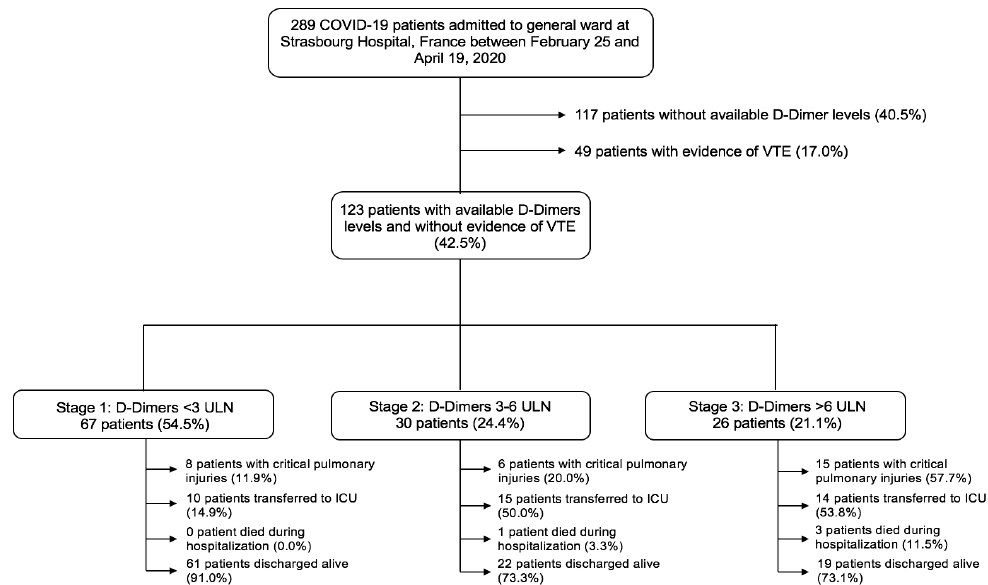
Figure 1. Flow-chart of the study. Of the 289 COVID-19 patients admitted to general ward at Strasbourg Hospital, France, between 25 February and 19 April 2020, this study included 123 patients, after we excluded 117 patients who did not have available D-Dimers levels and 49 patients with venous thrombo-embolism during hospitalization. According to a D-Dimers staging following the CAHA classification, 67 patients (54.5%) were in Stage 1, 30 (24.4%) in Stage 2 and 26 (21.1%) in Stage 3. Abbreviations: COVID-19, coronavirus disease 2019; ICU, intensive care unit; VTE, venous thromboembolism; ULN, upper limit of normal.